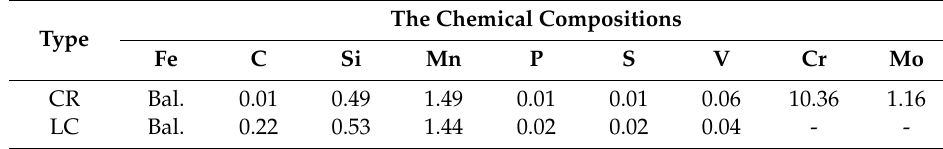
Table 2. Chemical compositions of steel bars